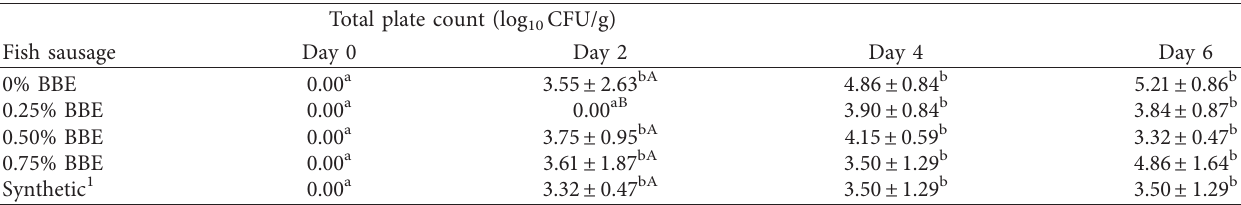
Table 5: Total plate count (log 10 CFU/g) of fish sausages fortified with different concentrations of bee bread extract (BBE) and synthetic additive potassium sorbate after 0, 2, 4, and 6 days of shelf life at 0 °